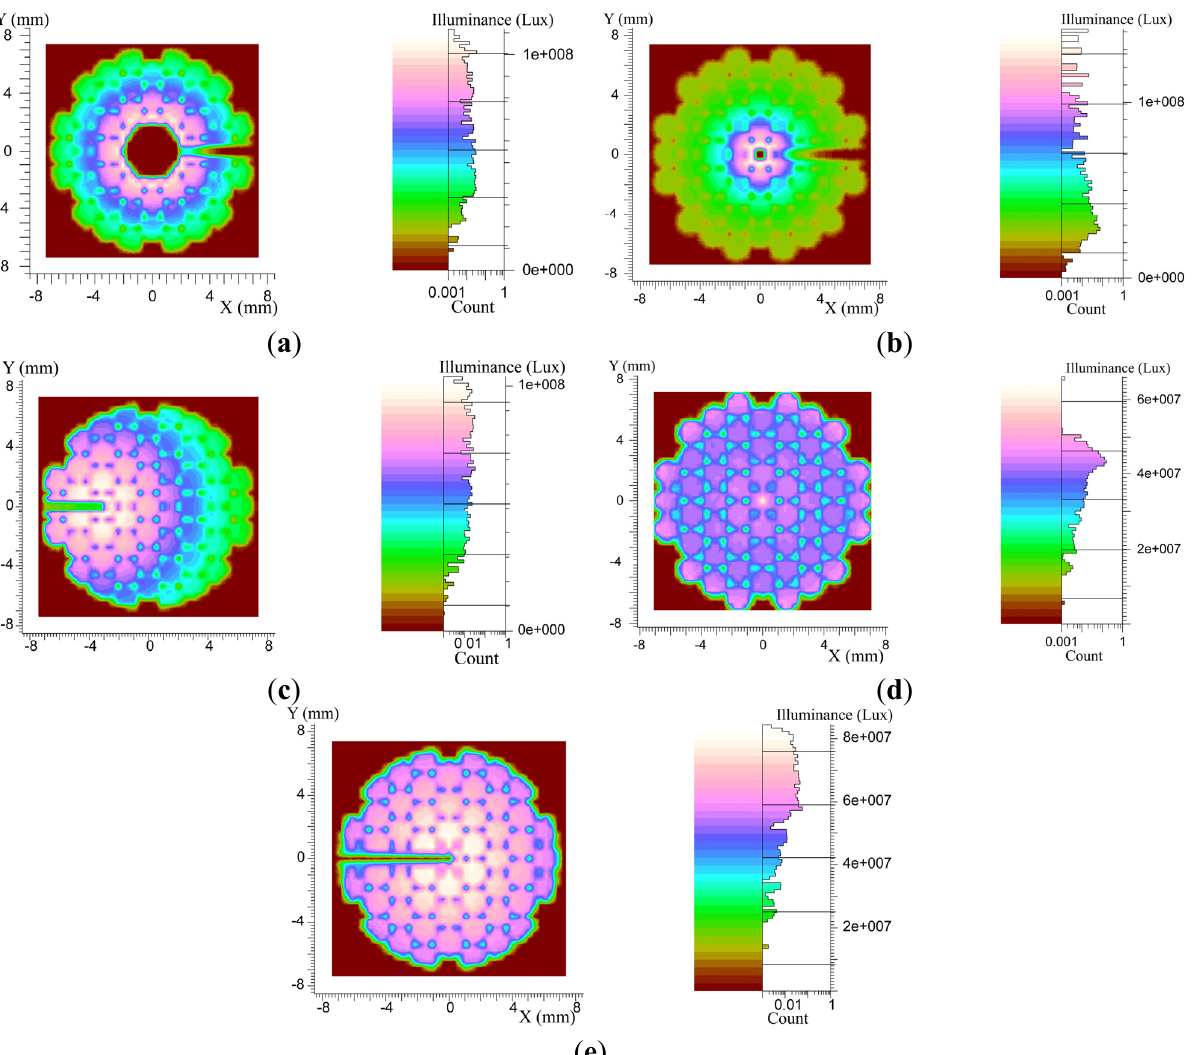
Figure 4. Uniform illumination on the surface of optical fibers’ ends for the ( a ) parabolic and flat reflectors; ( b ) parabolic and hyperbola reflectors; ( c ) offset parabolic reflector; ( d ) Fresnel lens and ( e ) proposed